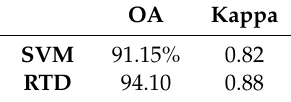
Table 6. OA and Kappa coe ffi cient of the SVM and RTD methods for the images from the Liaoning area.